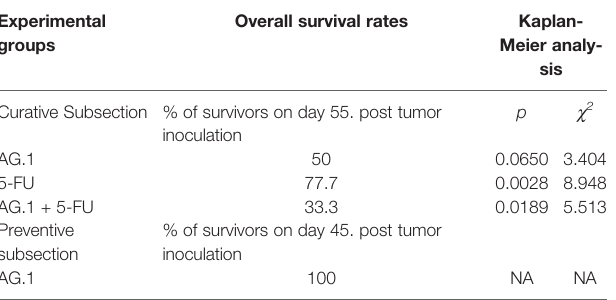
Overall survival rates Kaplan-